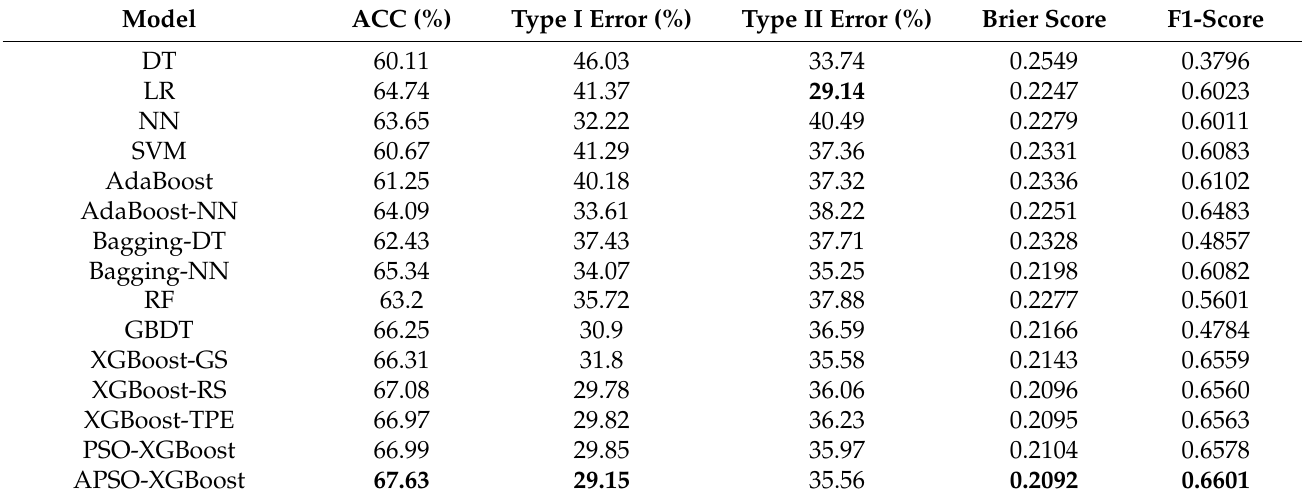
Table 9. Results of the measured performance of models on the P2P-LC data set.